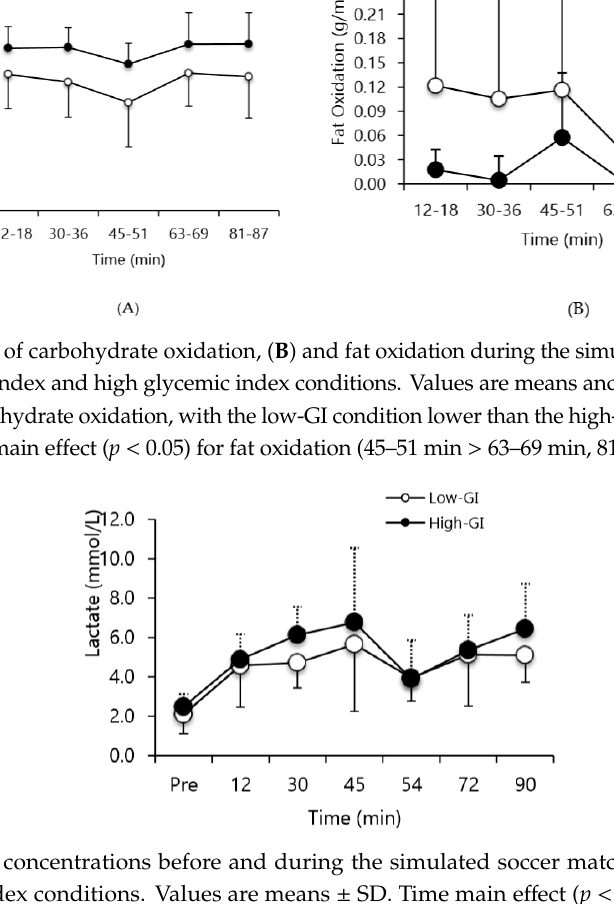
Figure 6. Lactate concentrations before and during the simulated soccer match between low- and high-glycemic index conditions. Values are means ± SD. Time main effect ( p < 0.05) with all values except 54 min > pre, and 45 min, 90 min > 54 min ( p < 0.05).